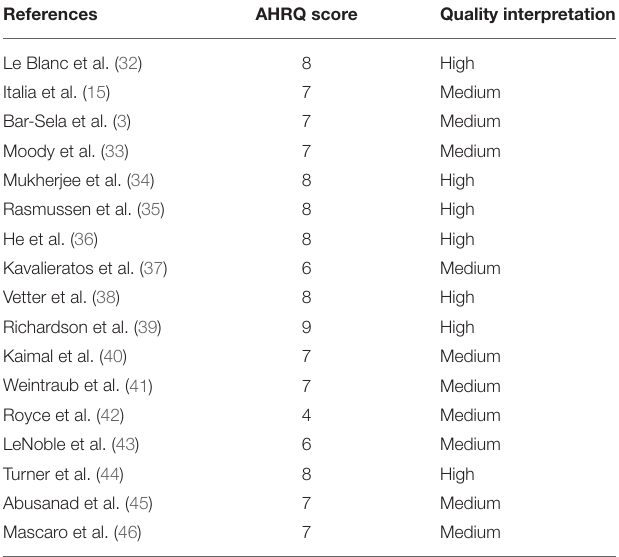
TABLE 2 | Summary of quality